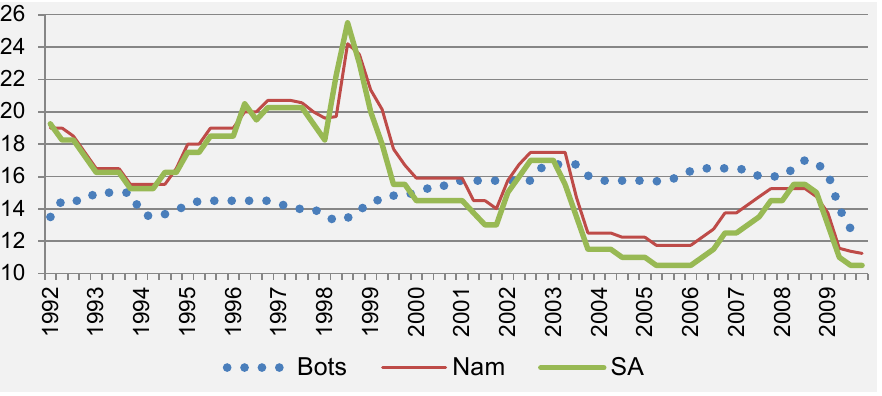
FIGURE 2: Prime lending rates Source: BoB, BoN,